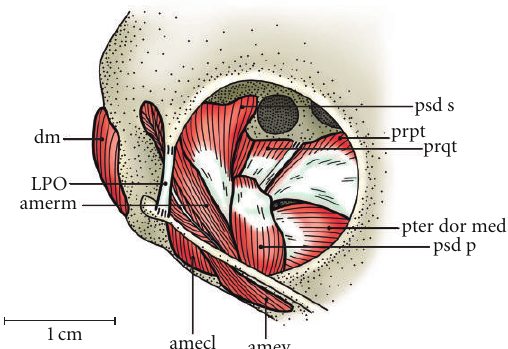
Figure 7: An oblique deep view of the jaw muscles of Reinwardtipicus validus. amecl: adductor mandibulae externus caudalis medialis; amerm: adductor mandibulae externus rostralis medialis; amev: adductor mandibulae externus ventralis; dm: depressor mandibulae; prpt: protractor pterygoidei; prqt: protractor quadrati; psd s: pseudotemporalis superficialis; psd p: pseudotemporalis profundus; pter dor med: pterygoideus dorsalis medialis. LPO: postorbital ligament.